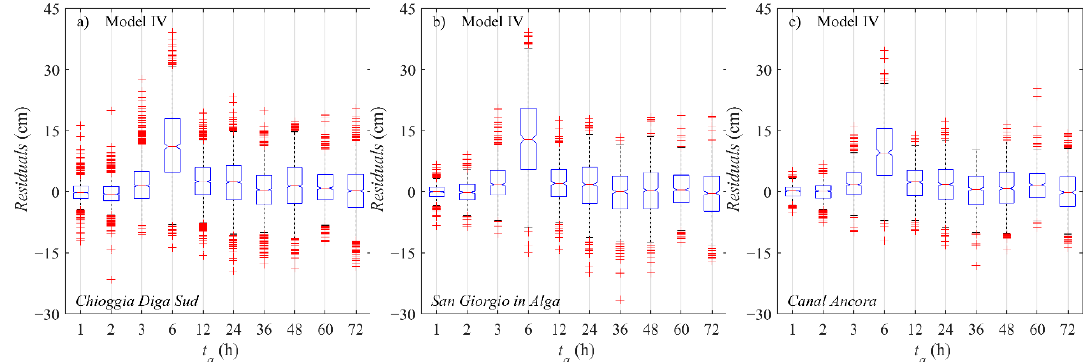
Figure 9. Tide prediction—Model IV, residuals box plots for h tide > 80 cm, expressed as the lag time t a increases, for: Chioggia Diga Sud (a) ; San Giorgio in Alga (b) ; Canal Ancora (c) . The lower end of each box plot denotes the 1st quartile (25th percentile); the upper end denotes the 3rd quartile (75th percentile). The “notch” represents the 95% confidence interval of the median.